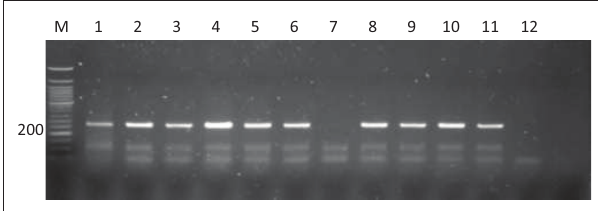
FIGURE 1: Agarose (1.5 % ) gel electrophoresis image of the nuc gene (270 bp). Lane M is a 50-bp DNA ladder, lanes 1 to 10 are test samples, lane 11 is a positive control and lane 12 is a negative control.